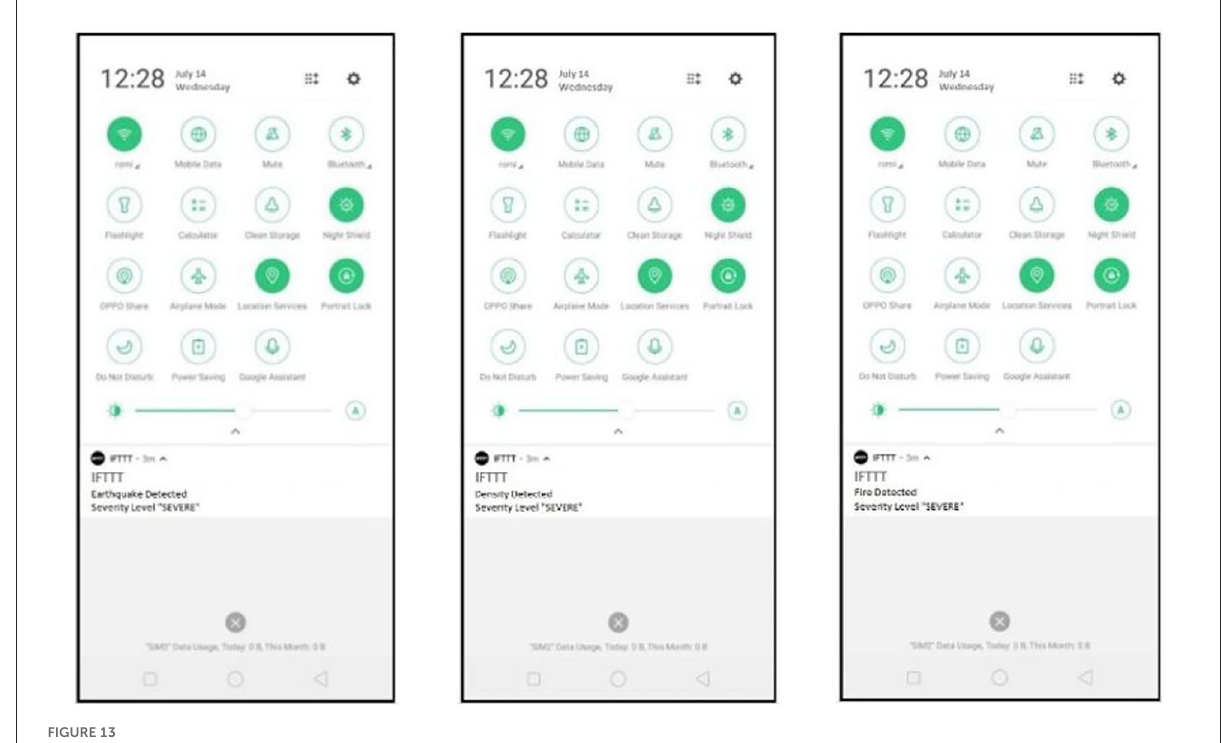
FIGURE13 IFTTT notifications received in the mobile phone’s notification panel.